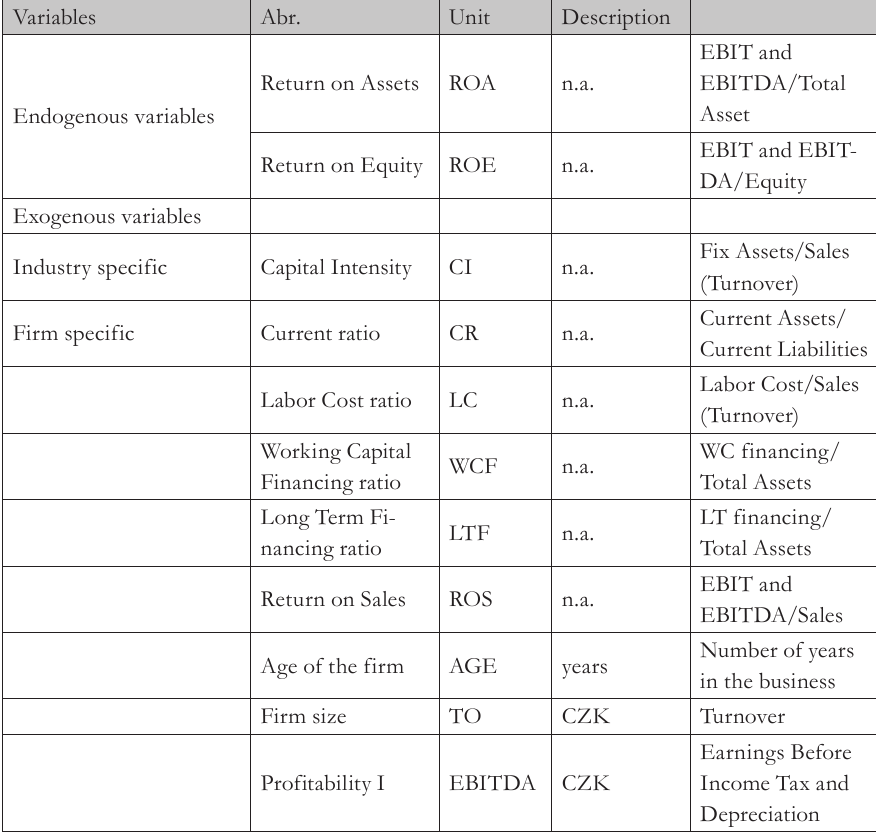
Tab. 1 – Overview of used determinants. Source: own research